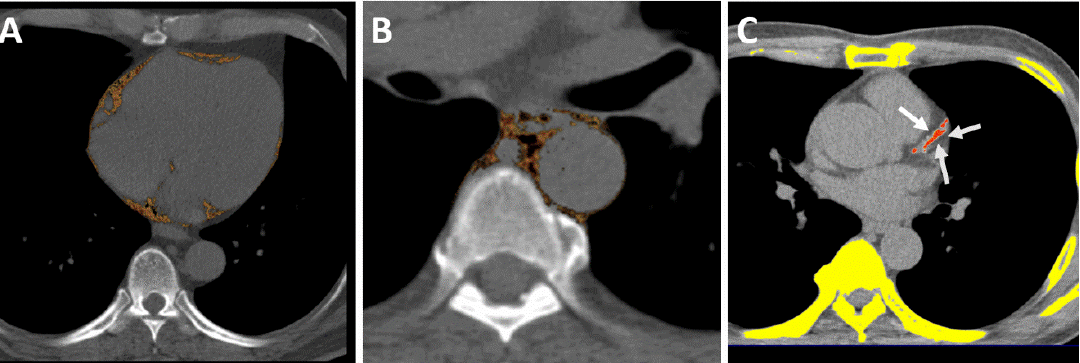
Figure 1. Multidetector computed tomography (MDCT) demonstrated visceral adiposity measures, including pericardial and thoracic peri-aortic fat tissue, and quantification of CACS. The pericardial fat was defined as the fat between the heart and the pericardium, as shown in axial view ( A ). ( A ) Pericardial adipose tissue. ( B ) Thoracic peri-aortic adipose tissue. ( C ) Semi-automatic quantification of CACS burden using Agatston scoring. *Orange color regions indicate visceral fat tissue. White arrows indicate coronary calcification lesions.